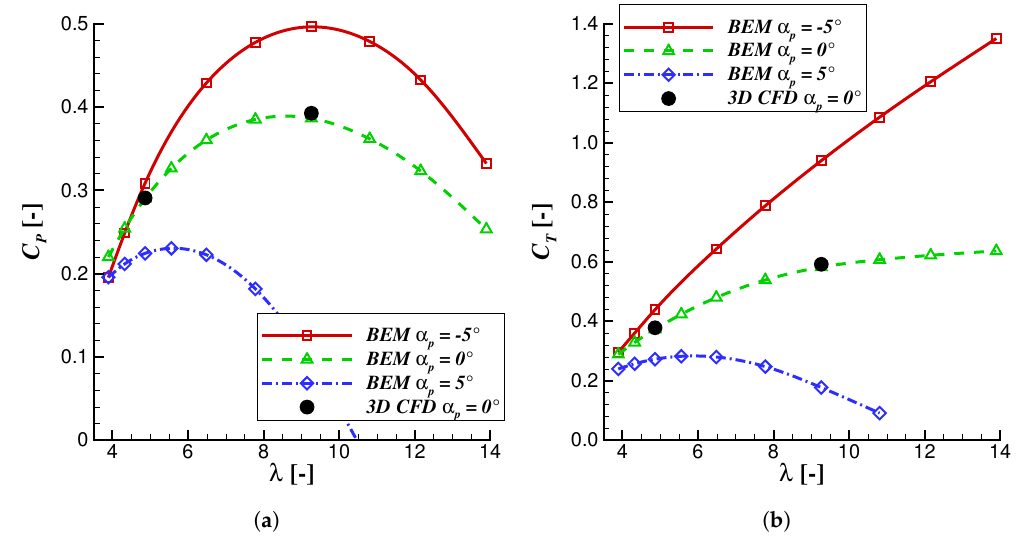
Figure 18. Power ( a ) and thrust ( b ) coefficients at various tip speed ratios and pitch